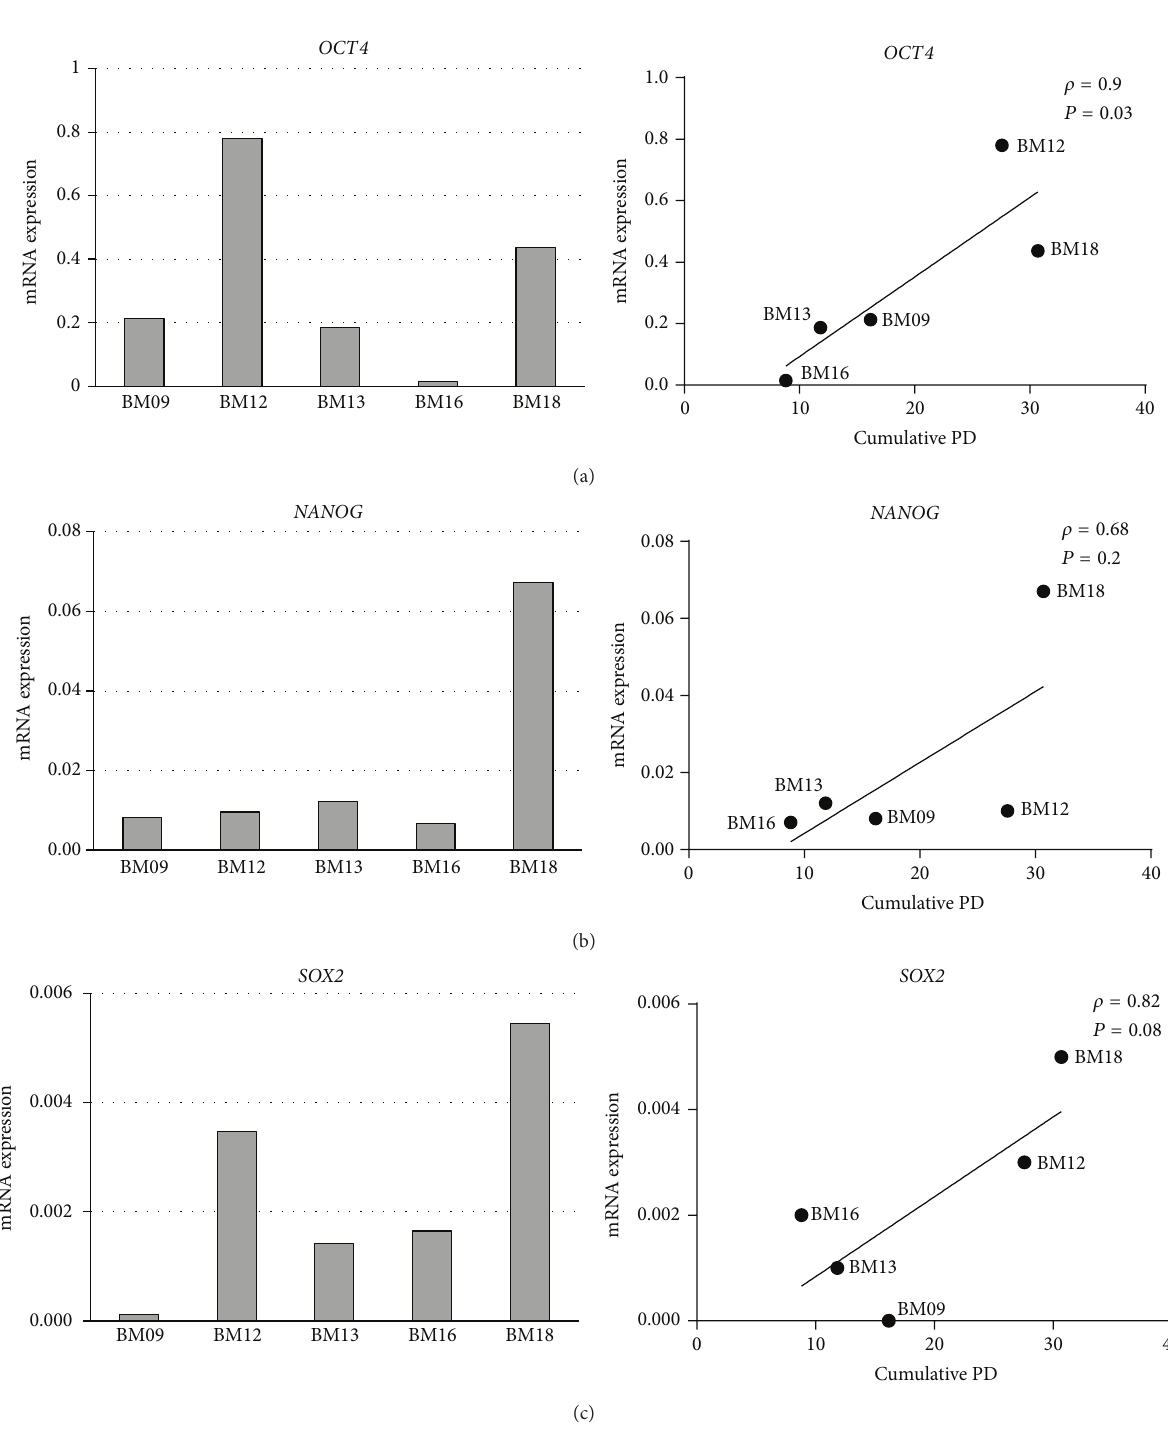
Figure 4: High OCT4 gene expression as a robust early marker of BM-MSC lifespan. The gene expression levels of (a) OCT4 , (b) NANOG , and (c) SOX2 in early passage cells from each donor were analyzed by real time PCR. Relative gene expression levels were quantified using the ΔΔ Ct method and the results were normalized to the expression of GAPDH. Bar graphs on the left represent the mean fold change of the normalized gene expression relative to a calibrator sample (reference RNA). These values were then plotted against the final PD number and statistically analyzed by Spearman correlation, as shown in the graphs on the right. The expression levels of OCT4 in early passage cells were positively correlated with lifespan. Results are representative of two independent experiments, each performed in duplicate, with similar